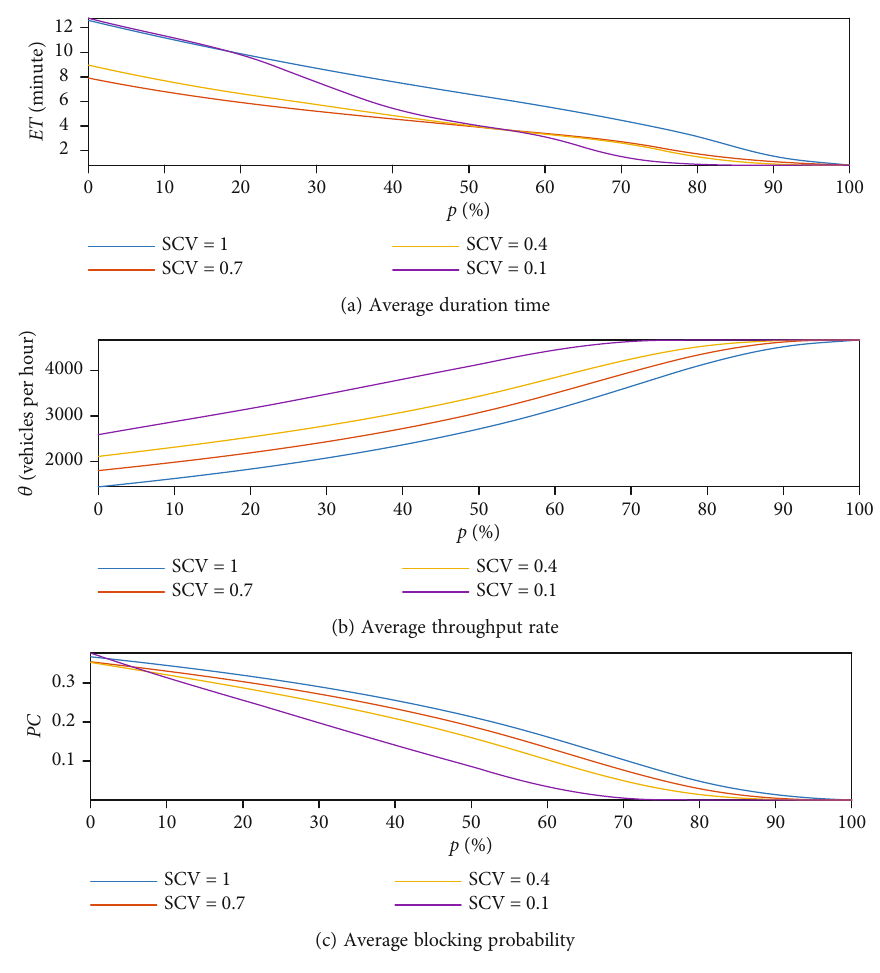
Figure 4: Average performance measures under a high tra ffi c